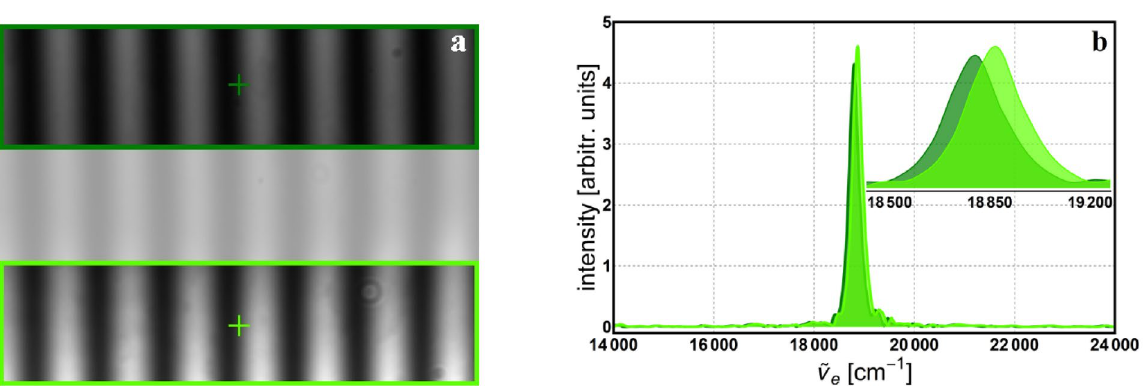
Figure 9. Green LED light (530 nm) with top half passed through a green filter (532 nm): ( a ) interferogram with selected areas and positions of the pixels used in the processing; ( b ) reconstructed monochromatic spectra for 2048 data